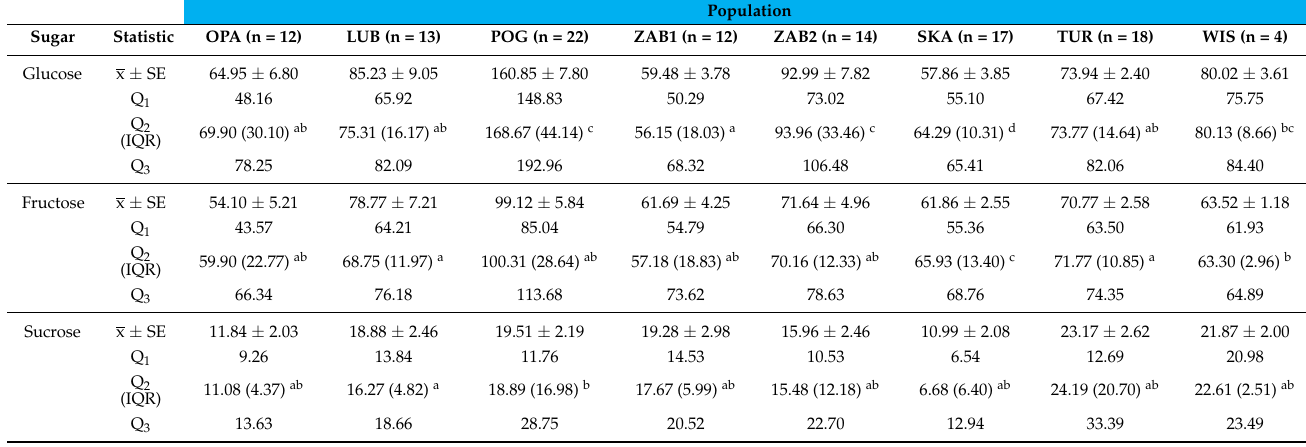
Table 3. The concentration of sugars ( µ M) in Neottia ovata nectar. Data represent the mean (x) ± standard error (SE), lower quartile (Q1), median(Q2), upper quartile (Q3), interquartile range (IQR). The same letters indicate statistically nonsignificant differences according to the pairwise Wilcoxon Rank Sum test with Benjamini-Hochberg adjustment ( p ≥ 0.05).